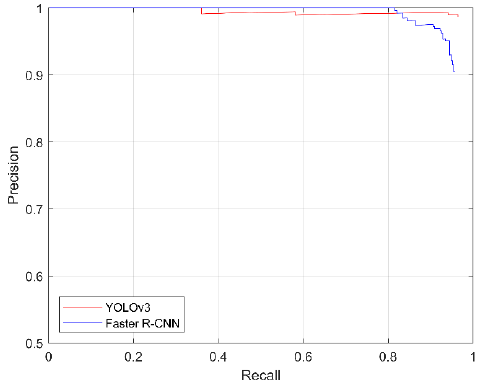
Figure 11. Precision-recall curves for the YOLOv3 and Faster R-CNN neural networks.